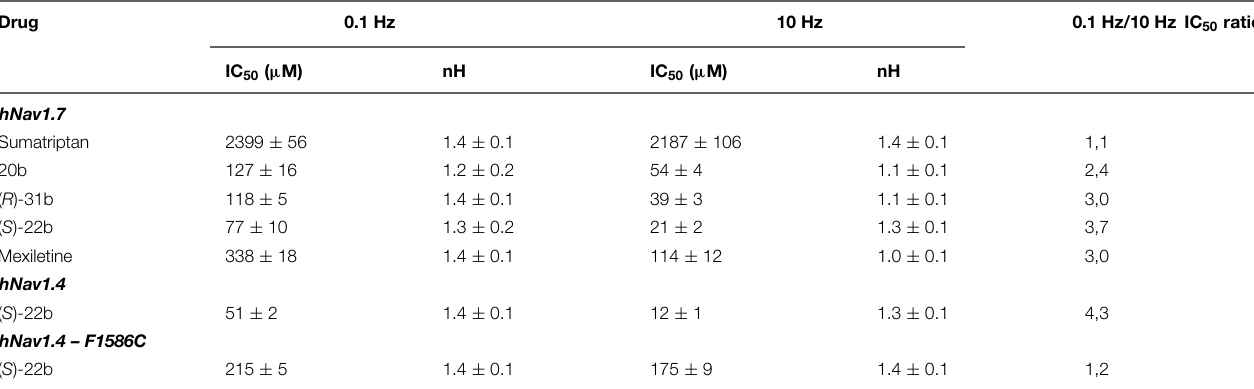
TABLE 1 | Comparison between half-maximum inhibitory concentrations of sumatriptan and its analogs on hNav1.7 sodium channels and of ( S )-22b on wild-type and mutated hNav1.4.